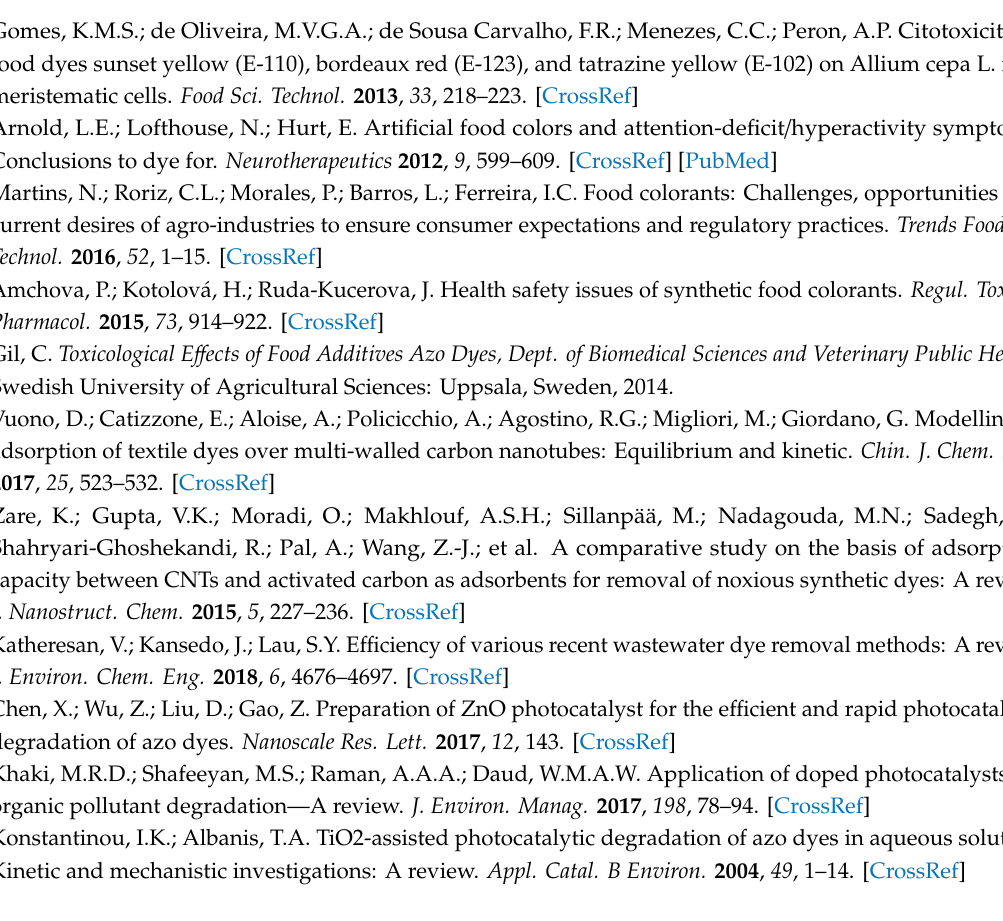
Figure S1: UV-Vis spectra changes of FB1 at di ff erent irradiation times, Figure S2: Root growth and seed germination percentage of L. sativum L. in FB1 solution during the HPO process, Figure S3: Pseudo-first-order kinetic rate constants for the photocatalytic mineralization of FB1 using TiO 2 and ZnO catalysts, Figure S4: The variation of GI % versus time for detoxification of FB1 by UV-TiO 2 and UV-ZnO processes at di ff erent pH values, Figure S5: Variation of reciprocal of constant rate versus di ff erent initial concentrations of FB1 at di ff erent pH values, Figure S6: Adsorption isotherm of FB1 on TiO 2 surface, Figure S7: Adsorption isotherm of FB1 on the ZnO surface, Figure S8: Establishment of Langmuir monolayer adsorption constants for adsorption of FB1 on TiO 2 catalyst at di ff erent pH values, Figure S9. Establishment of Langmuir monolayer adsorption constants for adsorption of FB1 on ZnO catalyst at di ff erent pH values, Figure S10: Evaluation of e ff ective concentration ( EC 50 ) for FB1, Figure S11: Chemical structure of Food Black 1 (FB1), Figure S12: Schematic view of the photo-reactor, Figure S13: The calibration chart for measuring FB1 concentration at di ff erent pH values of 5, 6.7 and 8. Table S1: Pseudo-first-order rate constant values for the di ff erent initial concentrations of FB1 at various pH